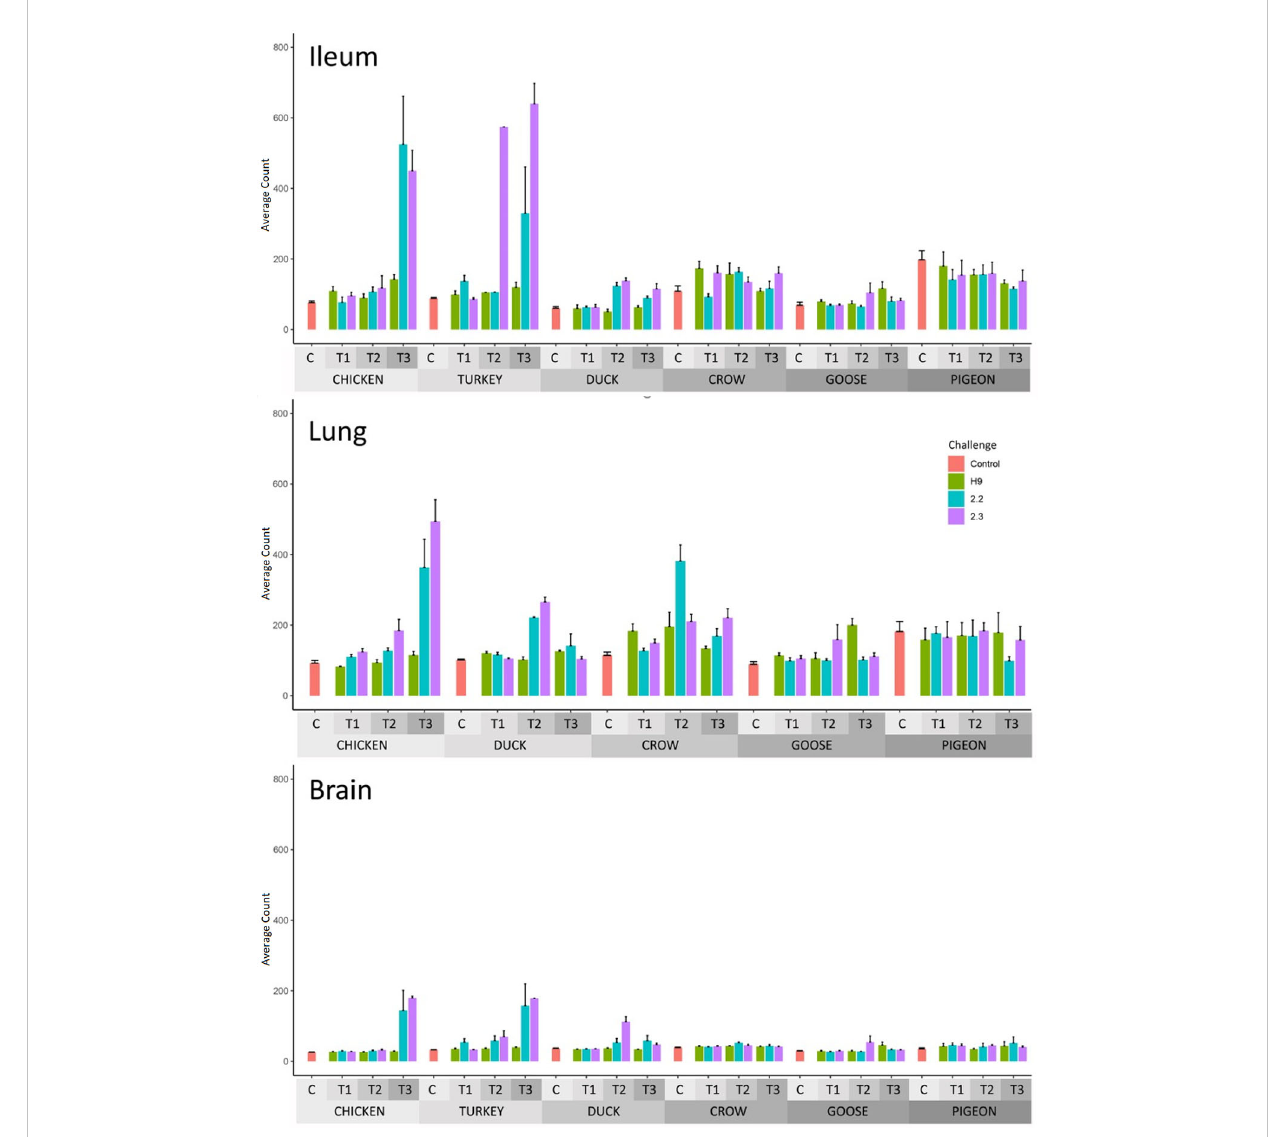
FIGURE 3 AverageRNAseqread count expression ofISGs in eachtreatment group with StandardError bars. Time1,2, 3 = 12h, 24h and 48h in chicken and turkey to 2.2 and 2.3infection. Time 1,2,3 = 12h, 48h and 5d in the remaining treatment groups. For treatment group sample sizes see Supplementary File